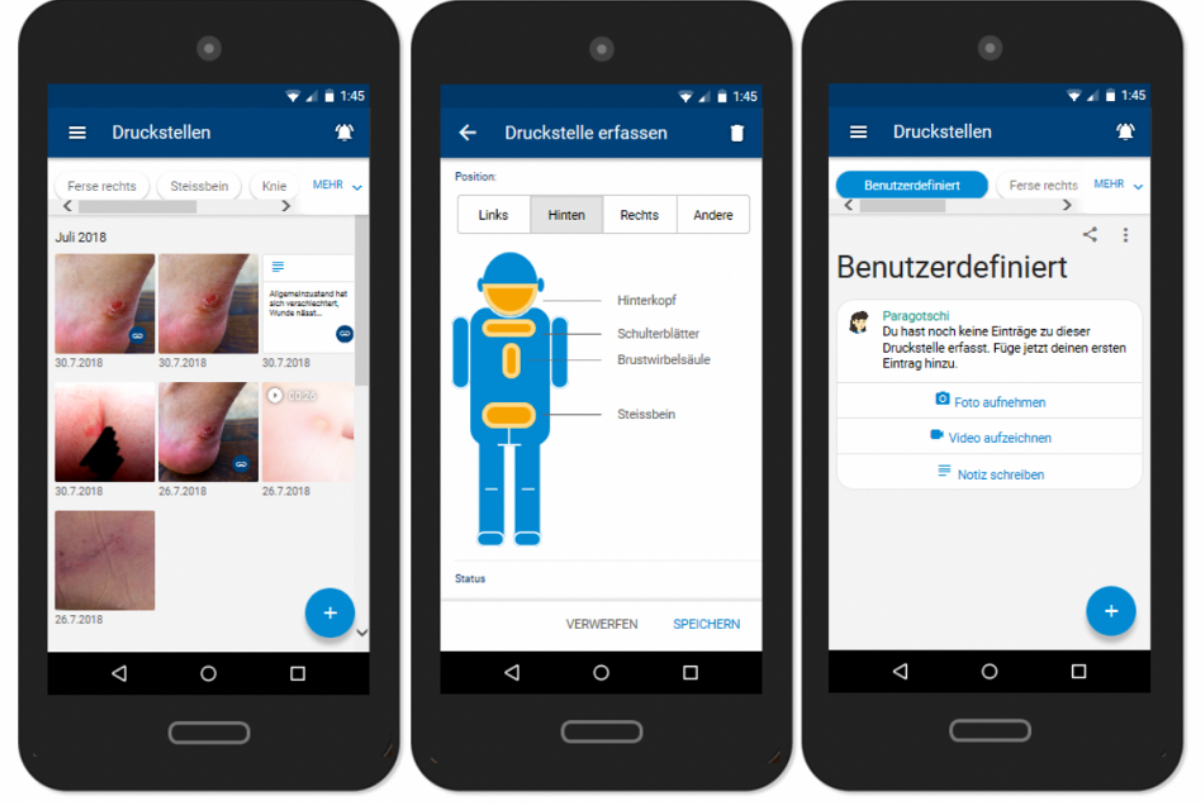
Figure 3. Pressure injury